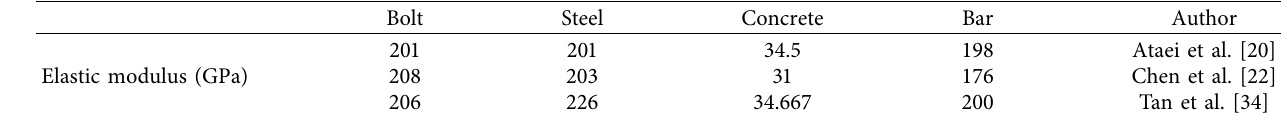
Table 2: Material properties.